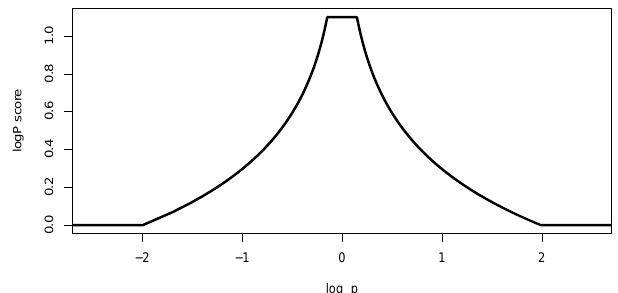
Figure 16. LogP score. The closer the logP value is to zero, the higher the score. The maximum value of the score is 1.1, and the minimum value is